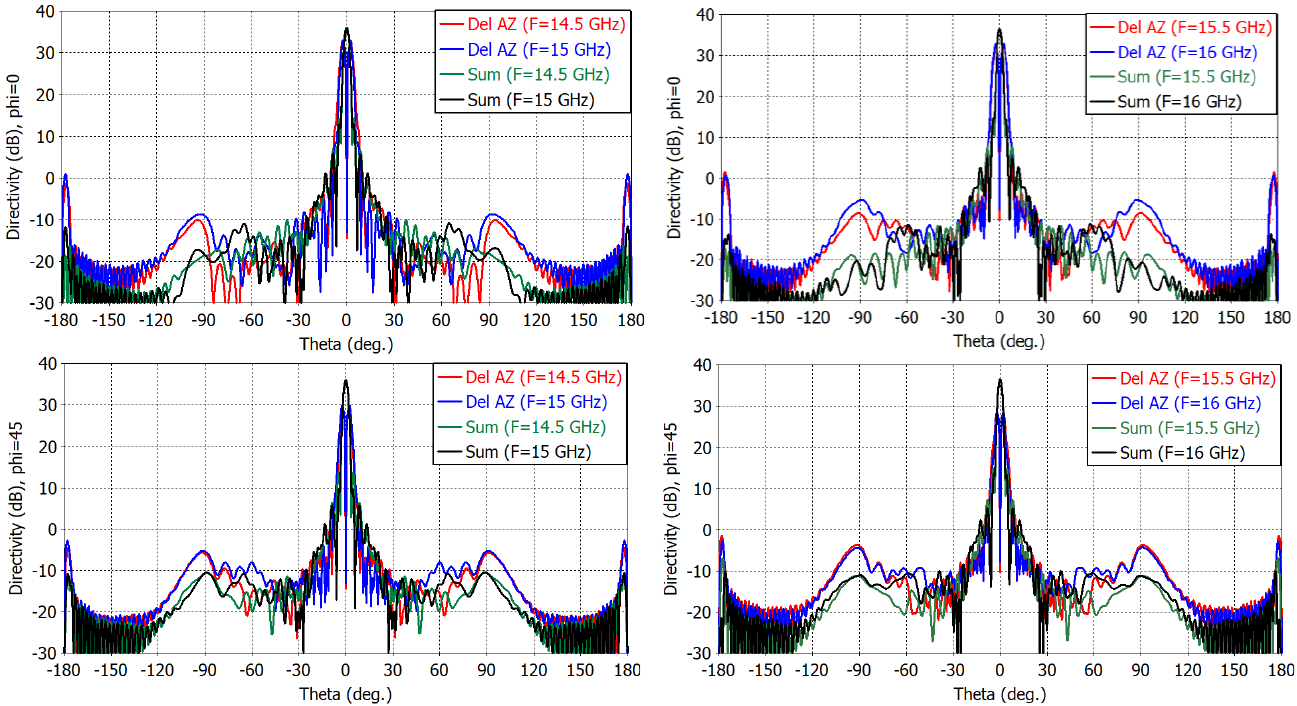
Figure 19. Directivity patterns of the reflector over ±180° angles.